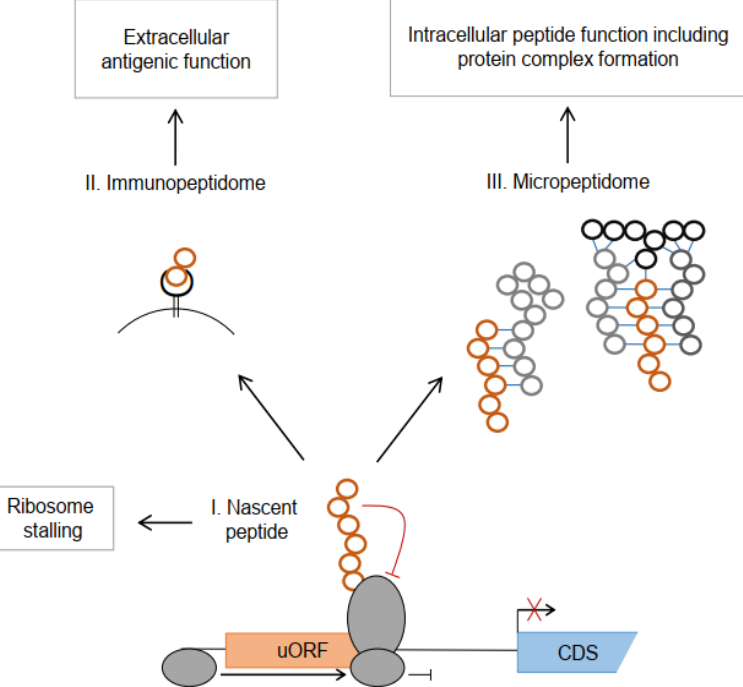
Figure 1. Intra- and extracellular functions of human uORF-encoded peptides. The nascent peptide ( I ) can induce ribosome stalling, mostly followed by transcript degradation, resulting in reduced translation of the main protein CDS, indicated by the crossed out arrow. After proteasomal degradation and processing via the MHC-related antigen presenting machinery, uPeptides contribute to the immunopeptidome ( II ). The uPeptides contribute to the micropeptidome ( III ) and may affect diverse cellular functions through interaction with key regulatory proteins or as part of protein complexes.